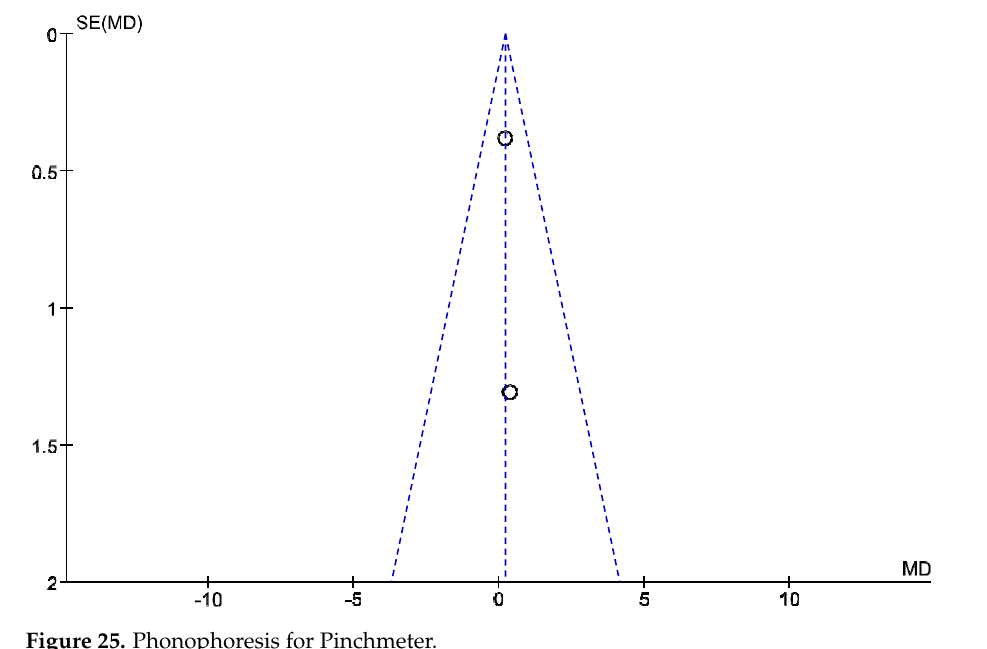
Figure 25. Phonophoresis for